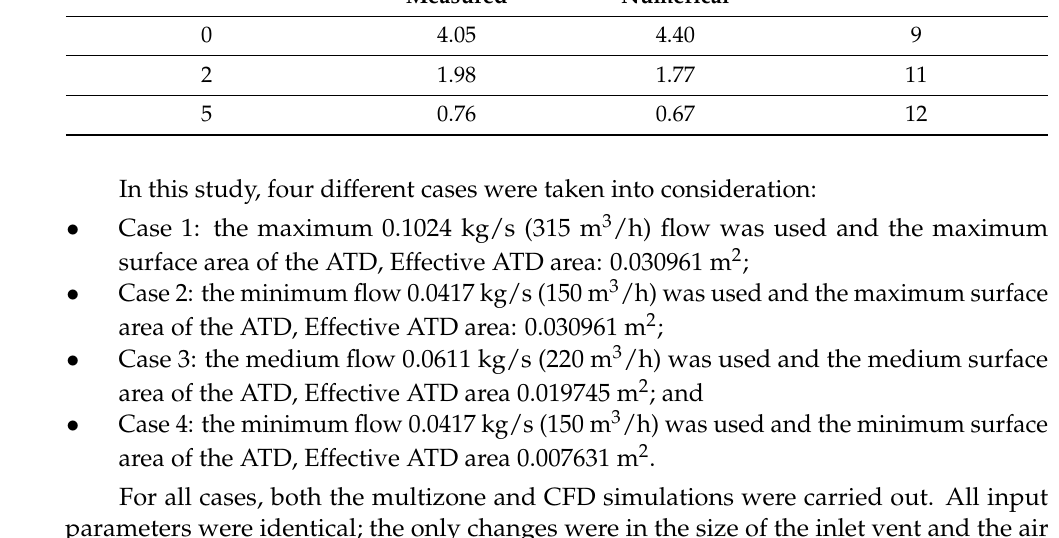
Table 1. Laboratory measurement and CFD simulation comparison of average air velocity. Distance from ATD (m)